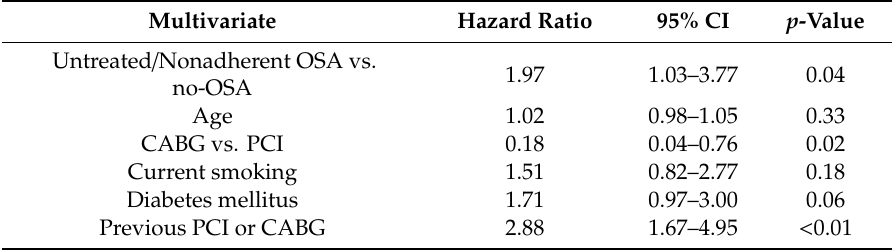
Table 5. Post-hoc Cox regression analysis of baseline covariables associated with risk for adverse cardiovascular outcomes in revascularized ACS patients with untreated / nonadherent OSA and no-OSA ( n = 255; 60 patients reached the composite endpoint). Multivariate Hazard Ratio 95% CI p -Value Untreated / Nonadherent OSA vs.